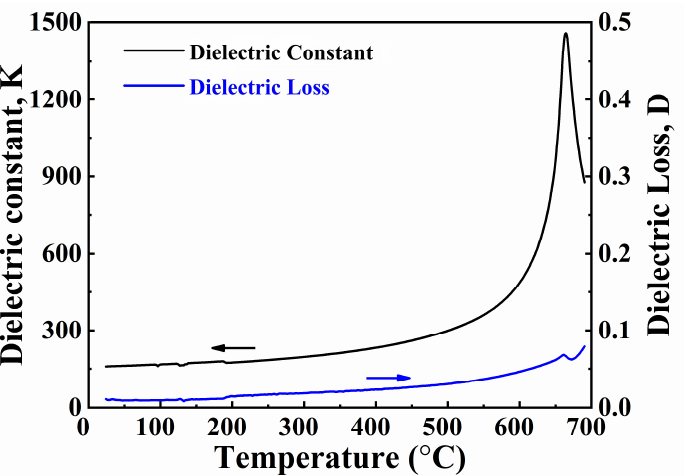
Figure 2. Dielectric constant K (black curve) and dielectric loss D (blue curve) of NBT-Nb-Mn ceramics sintered at 980 °C measured at 1 MHz.